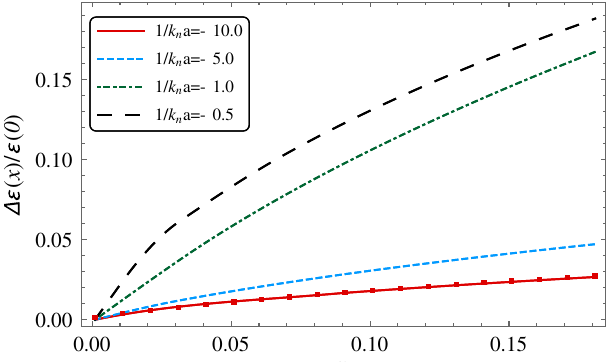
FIG. 10. The dependence Δ ε ð x Þ of the zero-momentum polaron energy on the impurity concentration x for mass ratio m=m 40 = 7 , T ¼ 0 , k ¼ 0 . 2 , and various impurity-boson scattering a n B lengths. We also show the perturbative result Eq. (15) for 1 =k a ¼ − 10 (red n